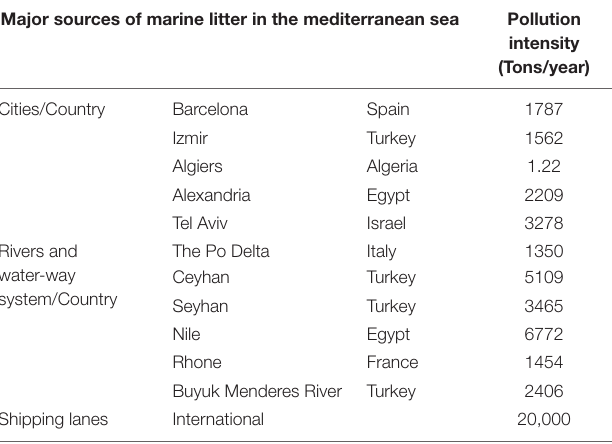
TABLE 1 | Major sources of Marine litter in the Mediterranean Sea with pollution